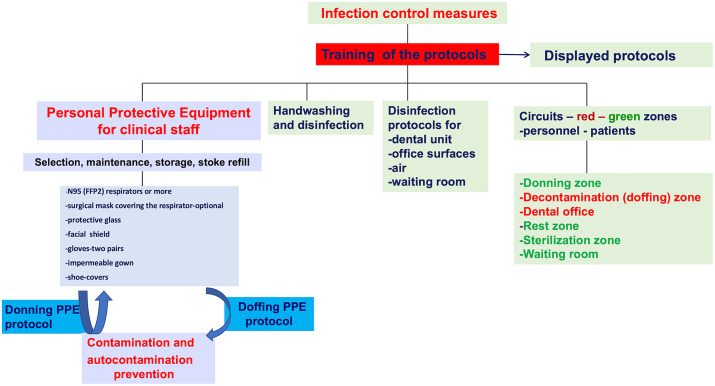
Infection control in the dental setting.9,15,44